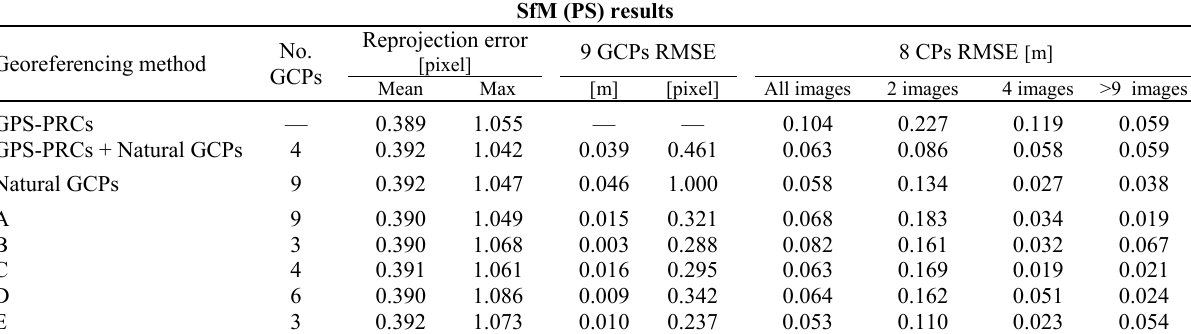
Table 3. Dataset characteristics and image processing results for the tested geo-referencing approaches.